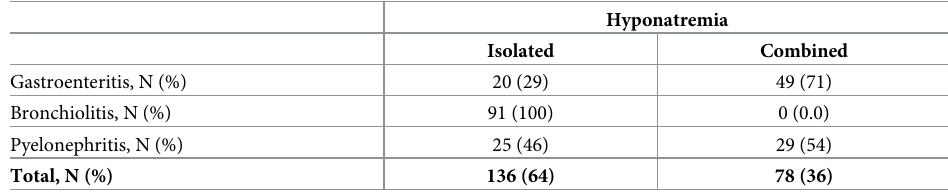
Table 2. Isolated and combined